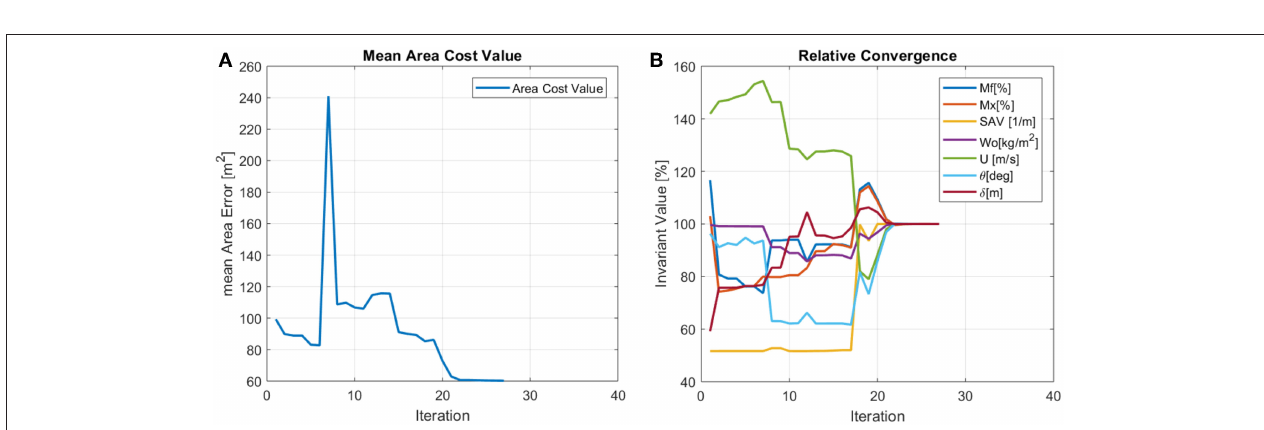
FIGURE 7 | Convergence of the assimilation process for Case A (20 min of assimilation). (A) Mean area error between observed and assimilated fronts. (B) Relative convergence for each of the 7 optimized parameters.